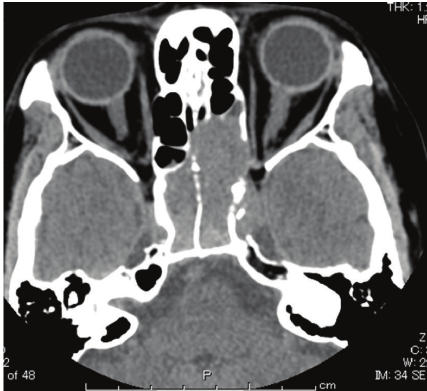
Figure 2: CT findings. In both the left and right sphenoid sinuses, soft tissue shadows accompanying skull base damage are apparent.